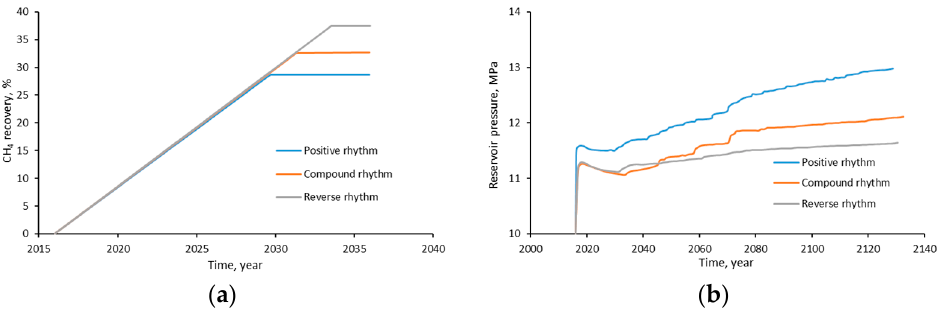
Figure 22. The variation curves under different reservoir rhythms. ( a ) CH 4 recovery; ( b ) Reservoir